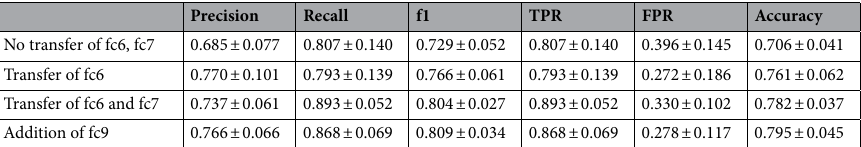
Precision Recall f1 TPR FPR Accuracy